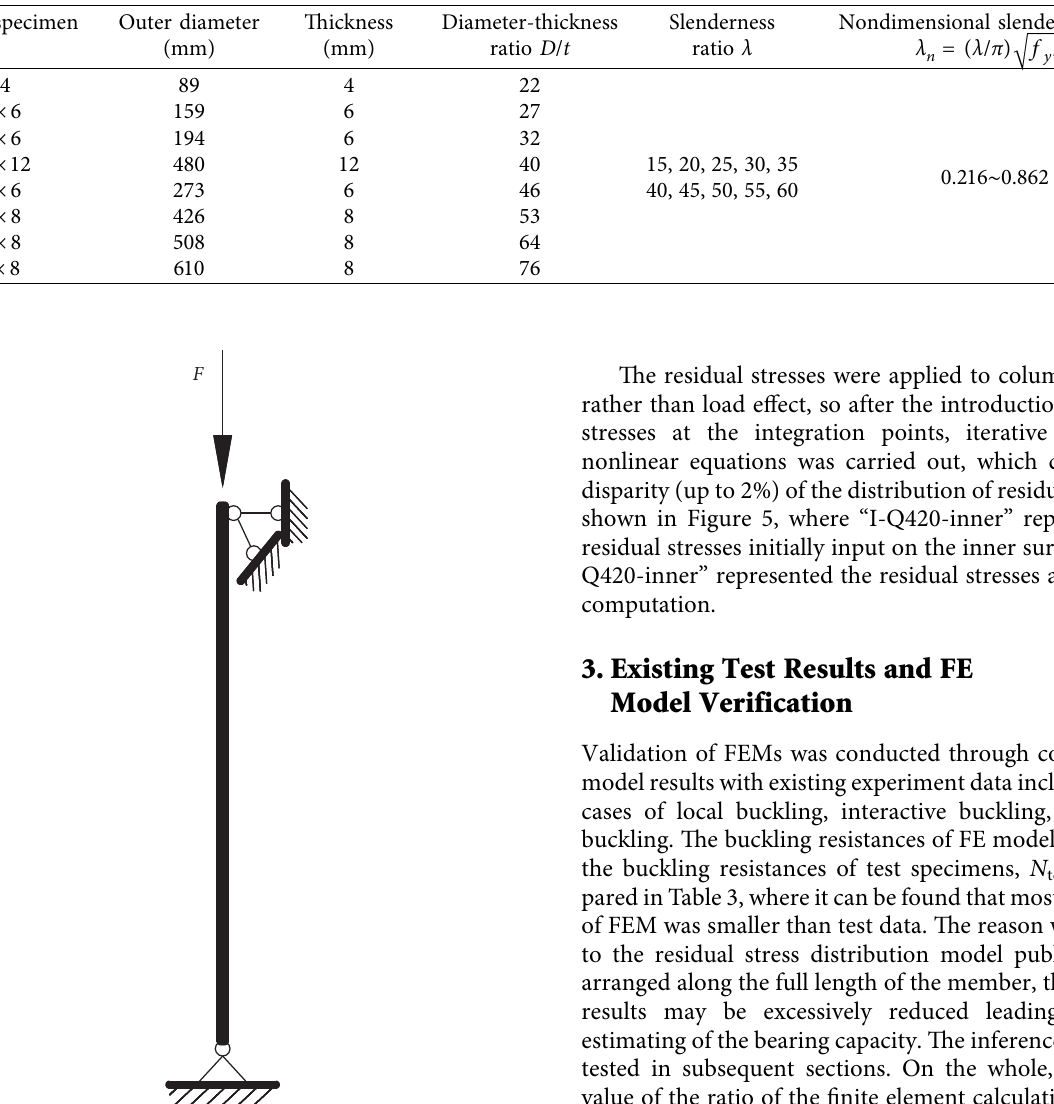
Table 1: Finite element analysis specimens.